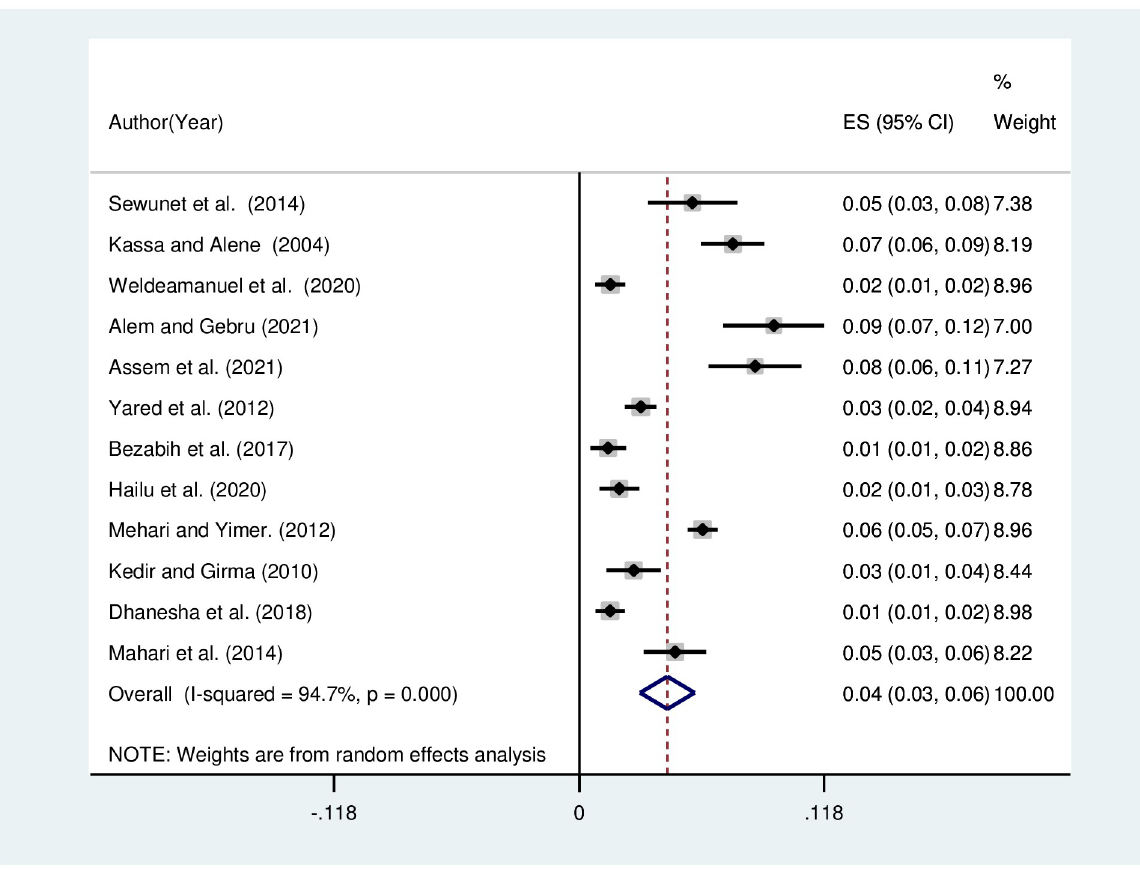
Fig 5. Funnel plot showing the pooled prevalence of visual impairment due to myopia in Ethiopia, 2021.